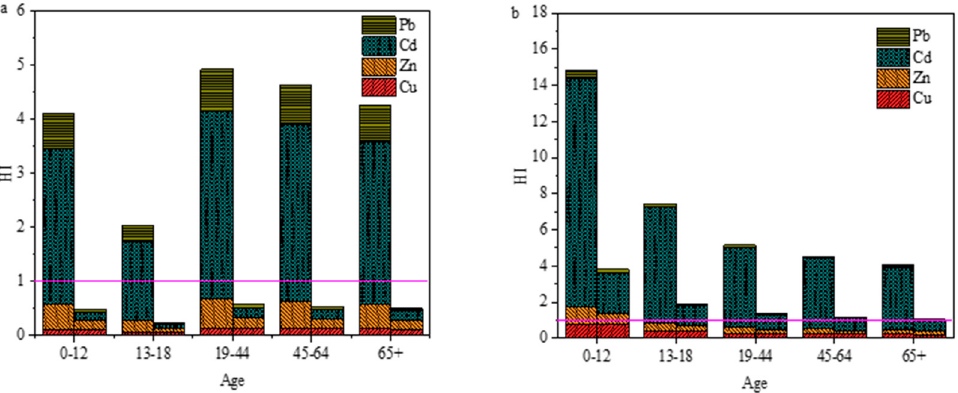
Figure 6. Hazard index (HI) in different scenarios of consumption. ( a ) vegetables (left columns represent leafy vegetables and right columns represent non-leafy vegetables); ( b ) rice (left columns represent local rice and right columns represent market rice).